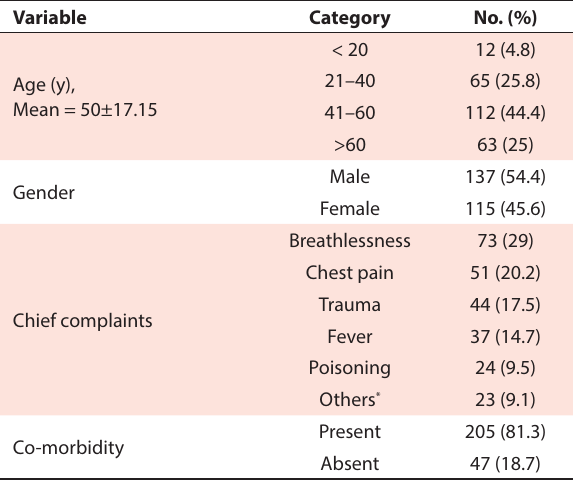
Table 1. Baseline characteristics of study participants (n = 252)